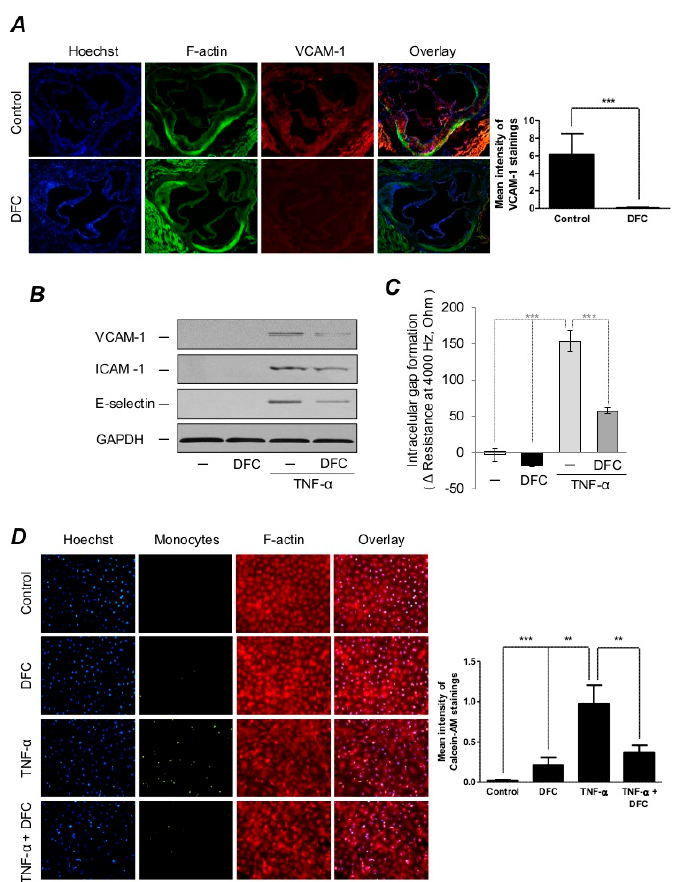
Figure 3. DFC prevents TNF- α -induced expression of adhesion molecules in ApoE − / − mice and endothelial cells, preserves endothelial integrity and inhibits monocyte adhesion. ( A ) 8-week-old ApoE − / − mice were fed ad libitum with an atherogenic diet containing 5% fat and 1.25% cholesterol and divided into DFC group ( n = 17) receiving 160 mg / kg intraperitoneal DFC and control group ( n = 21) receiving physiological saline every second day for 8 weeks. Aortas (5 per group) were stained for DNA (Hoechst 33258, blue), F-actin (cytoskeleton, phalloidin-FITC, green) and VCAM-1 (AF647, red), respectively. Quantification of VCAM-1 mean intensity was performed with Image J software. Scale bar: 0.2 mm. ( B ) Human Umbilical Vein Endothelial Cells (HUVEC) were incubated with or without DFC (50 µ mol / L) for 16 h and treated with or without 1 ng / mL of TNF- α for 8 h. Representative Western blots showing VCAM-1, ICAM-1 and E-selectin protein expression in HUVEC normalized to GAPDH are shown. ( C ) HUVEC were cultured with or without DFC (50 µ mol / L) for 16 h in CM199 medium containing 5% FBS. Then, cells were incubated in the presence or absence of TNF- α (1 ng / mL) for 3 h. Transendothelial electrical resistance was monitored by the Electric Cell-substrate Impedance Sensing (ECIS) Z θ instrument over 3 h. ( D ) Confluent HUVEC were incubated with or without DFC (50 µ mol / L) for 16 h in CM199 medium containing 5% FBS. Then, cells were incubated with or without TNF- α (1 ng / mL) for 6 h followed by coincubation with calcein-labeled (5 µ mol / L) monocytes for 30 min at 37 ◦ C. Cells were then fixed and stained for DNA (Hoechst 33258, blue) and F-actin (cytoskeleton, red, iFlour 647). Quantification of Calcein-AM mean intensity was performed with Image J software. Images were taken with a fluorescent microscope at a magnification of 400 × . ** p < 0.01; *** p <